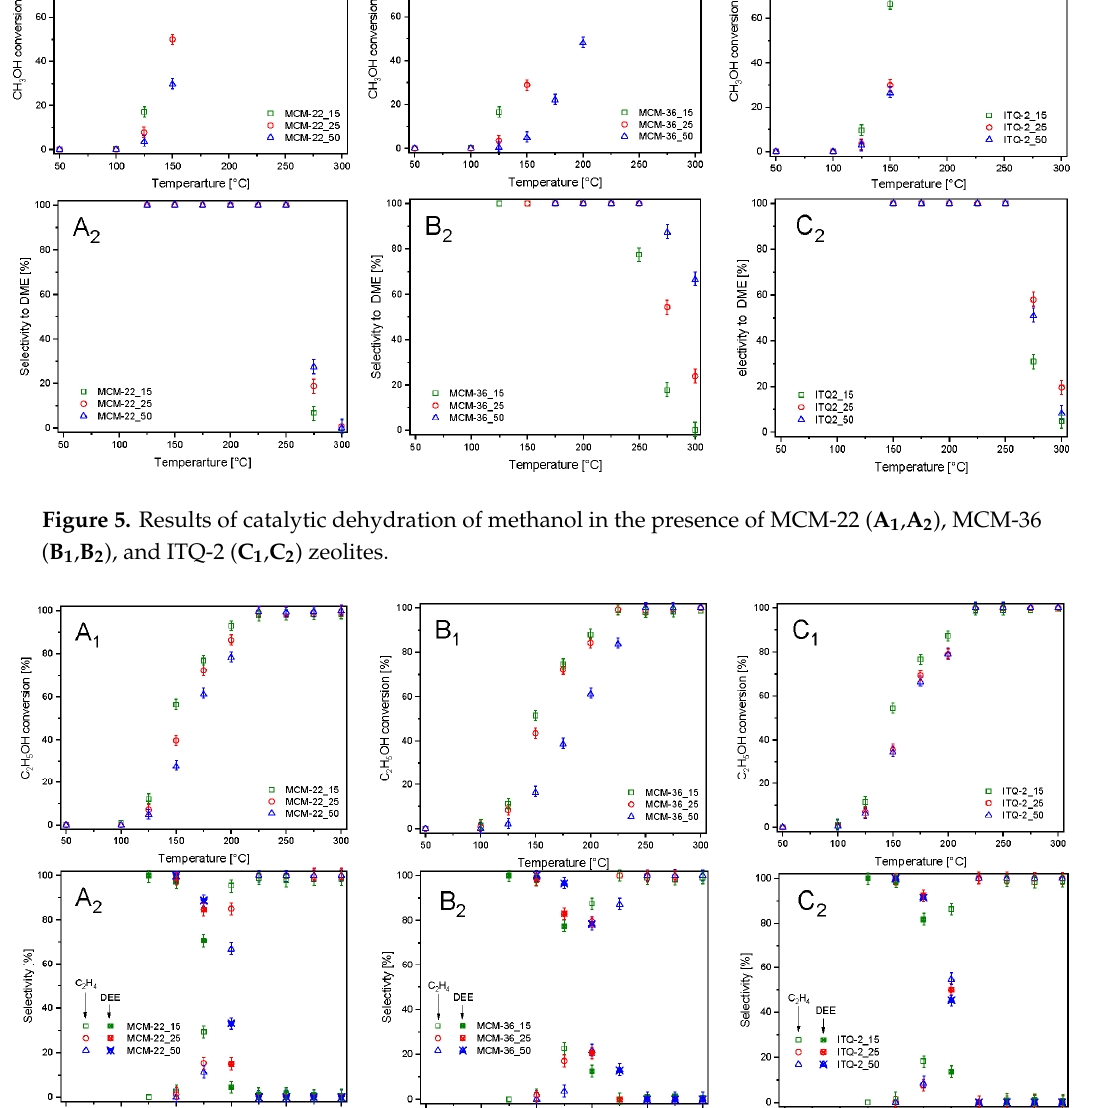
◦ C (Table 3) are in the range